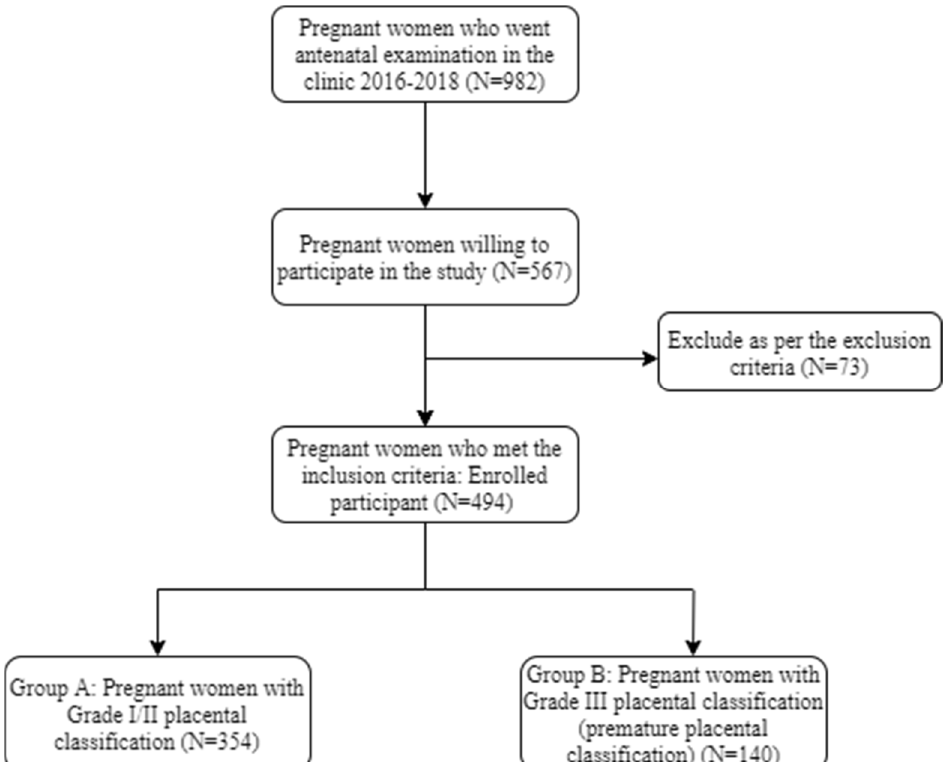
Figure 1. Flowchart showing participant selection criteria.